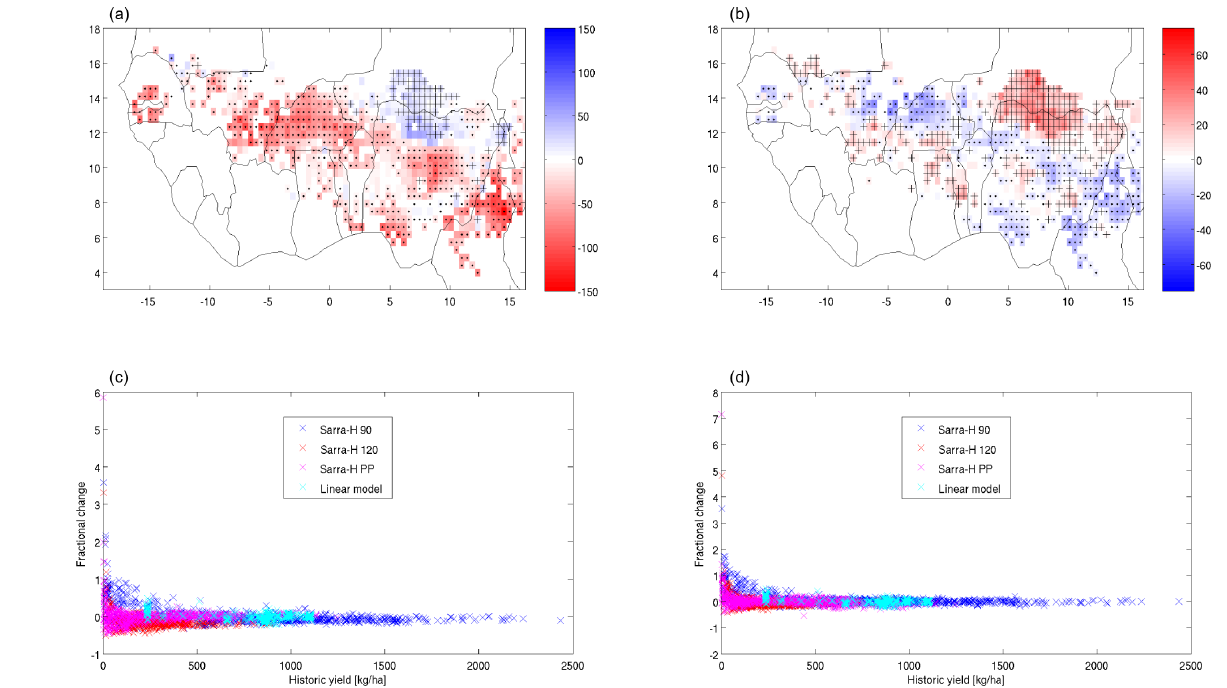
Figure 3. Change in sorghum yield and yield IAV between the historic and future climates. Panel (a) shows the change in yield where + indicates that in three crop models the change will be positive and · indicates that in three crop models the change will be negative. Panel (b) is the same as (a) except for IAV instead of yield. The units of the colour bar in the top plots is kilograms per hectare. Panel (c) shows the fractional change in yield against yield for all analysed grid cells. Panel (d) shows the fractional change in yield IAV against yield for all analysed grid cells.